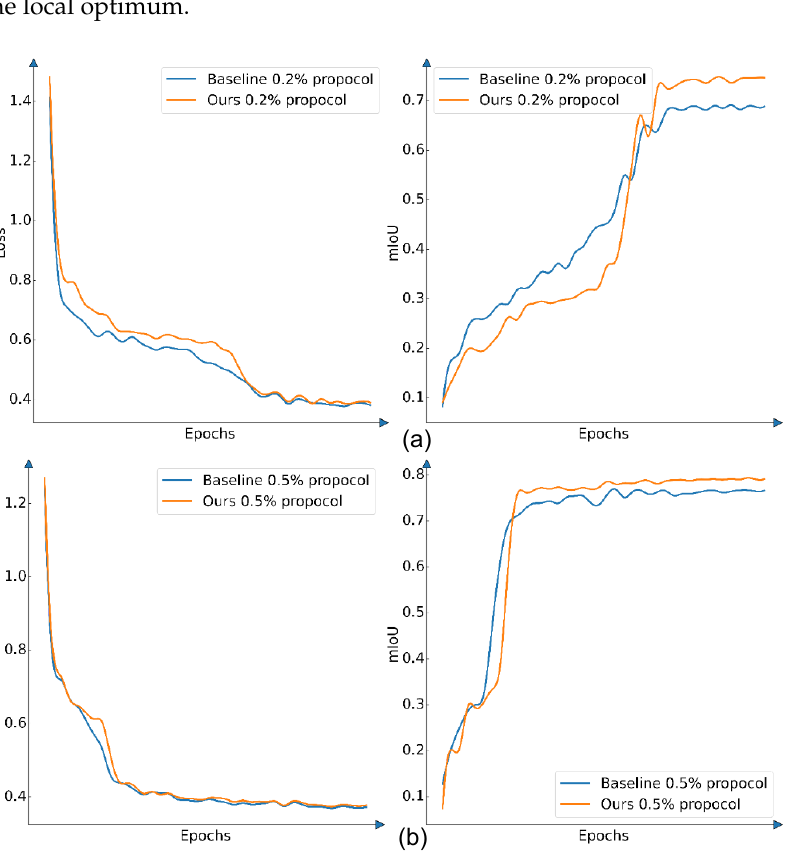
Figure 4. ( a , b ) show the difference between the baseline and our method in training loss and test set mIoU with 0.2 and 0.5% protocol training data. As for the mIoU performance, our method has worse performance but ends with better mIoU